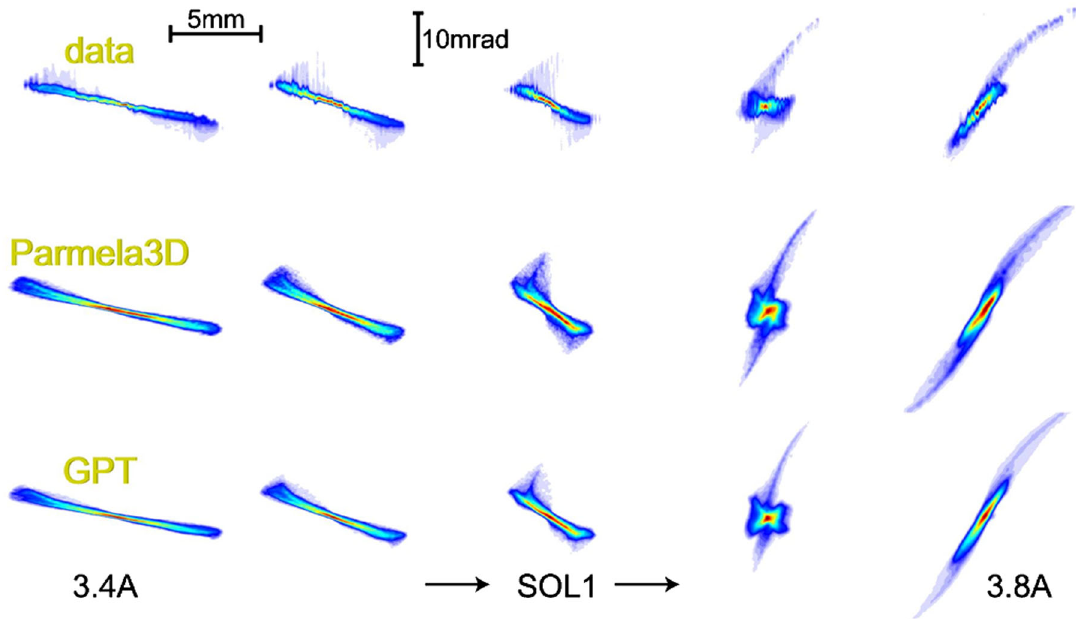
FIG. 15. (Color) Comparison of measured and simulated vertical transverse phase space distributions for 80 pC bunches at z ¼ 1 : 244 m . Data representing measurements, PARMELA3D , and GPT calculations are arranged in rows with different strength of the solenoid lens corresponding to column